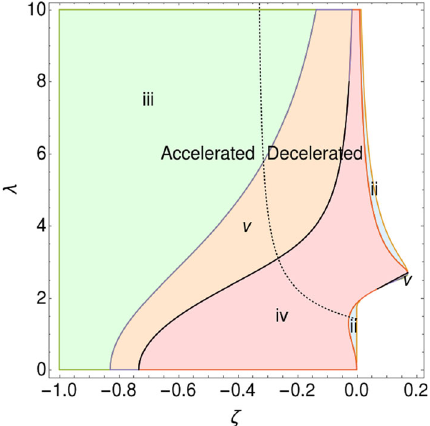
Fig. 5 Part of the region of existence of the critical point H − when α = β ≡ ζ . Region ii contains stable points, iii unstable points, iv spiralstablepoints,vspiralunstablepointsandcenterpointsarelocated on the black lines. The black dotted curve divides the accelerated and